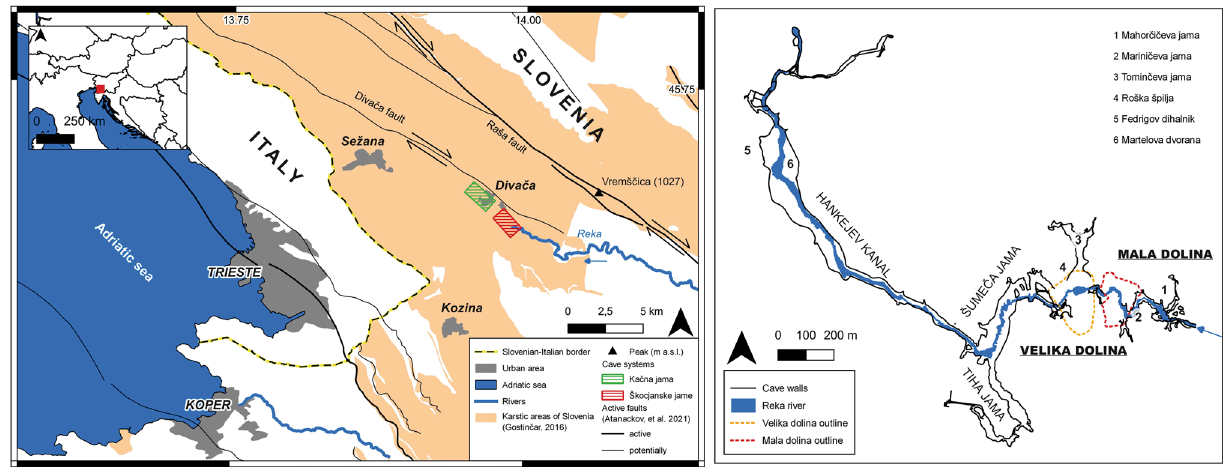
Fig. 1 Left—Structural geology of the wider area of the Škocjan Caves system, SW Slovenia. Right—Major passages in Škocjan Caves. Exten- sion of karst after [39], active faults after